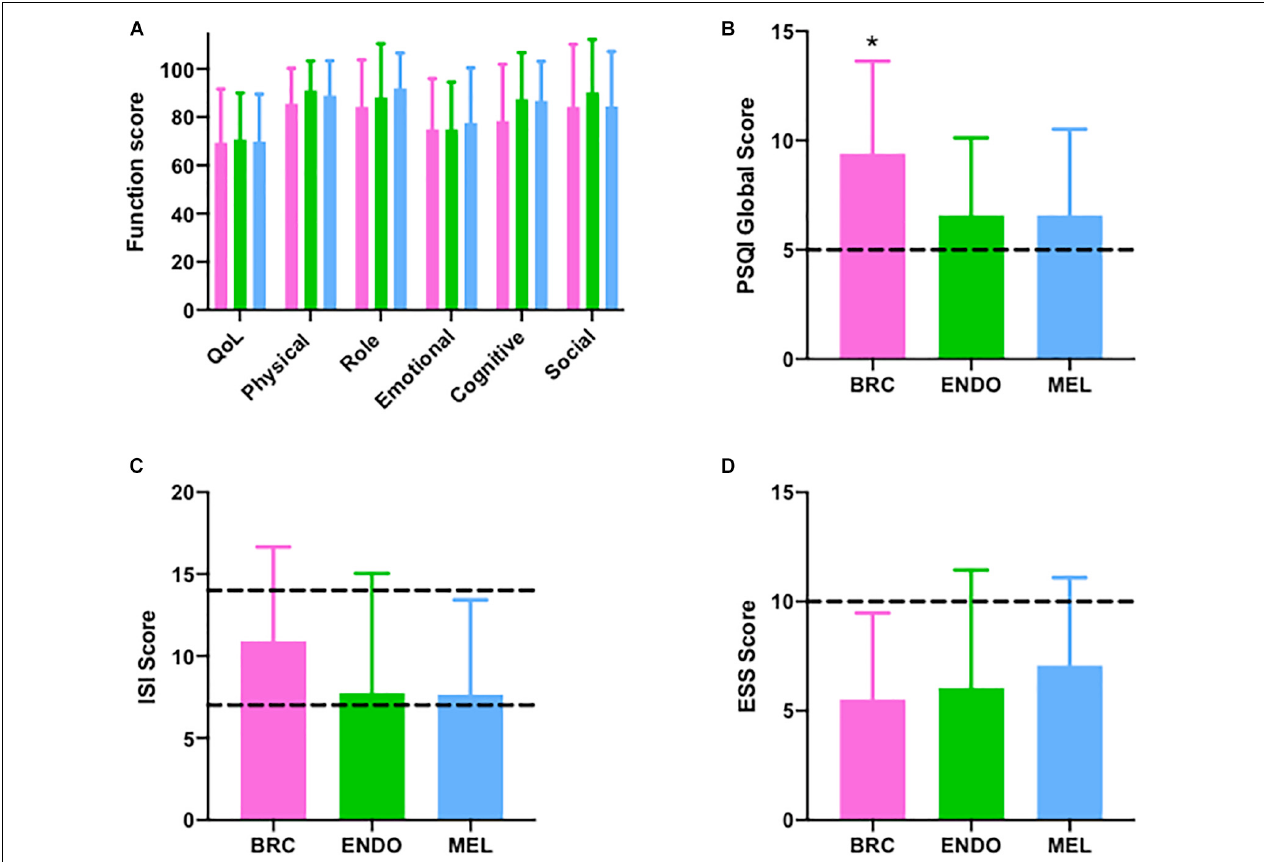
FIGURE 2 | Questionnaire outcomes in breast (pink; n = 35), endometrial (green; n = 24), and melanoma (blue; n = 29) cancer patients. (A) European Organization for Research and Treatment of Cancer EORTC QLQ-C30) questionnaire with quality of life (QoL) and individual function scores (physical, role, emotional, cognitive, and social), (B) Pittsburgh Sleep Quality Index (PSQI) > 5 indicates poor sleep quality (C) Insomnia Severity Index (ISI) (Dashed lines ISI > 8 sub-threshold insomnia, > 14 clinical insomnia), (D) Epworth Sleepiness Scale (Dashed lines: ESS > 10 indicated daytimes sleepiness). BRC, breast cancer; ENDO, endometrial cancer; and MEL, melanoma cancer, * p <